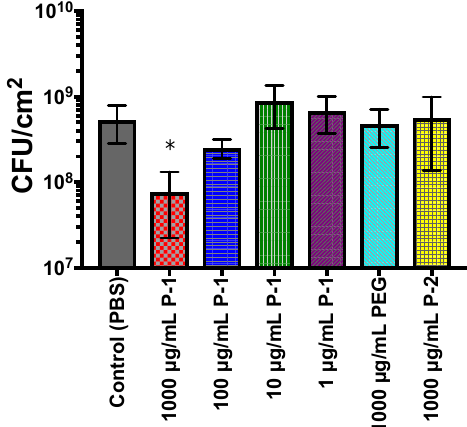
Figure 8. Viable bacteria evaluation of polymer-modulated biofilm formation. Viable bacteria dependence on polymer concentration after 24 hours of incubation in the presence of P-1, PEG, or P-2. PBS was used as a positive control. The experiment was performed in duplicate, and the absorbance was determined as the average of data for each experiment. The data points and error bars represent the average and s.d from data in three independent experiments ( n = 3), with significance (* p ≤ 0.05) indicated against control (PBS).